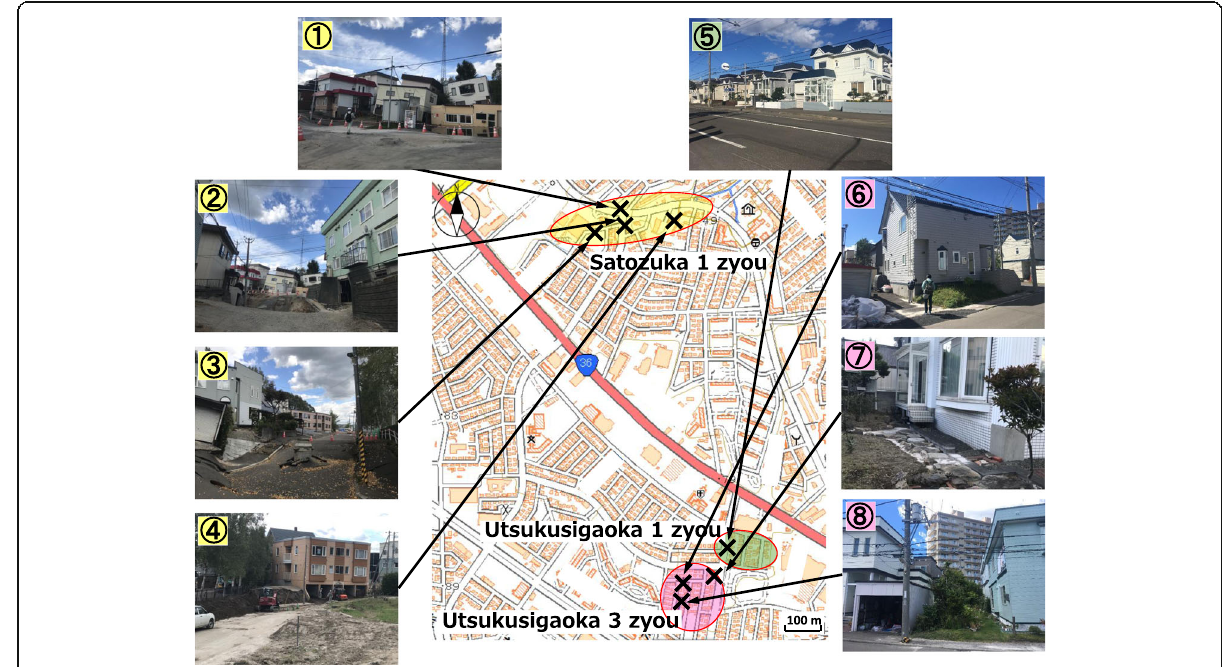
Fig. 4 Liquefaction-induced damage at each